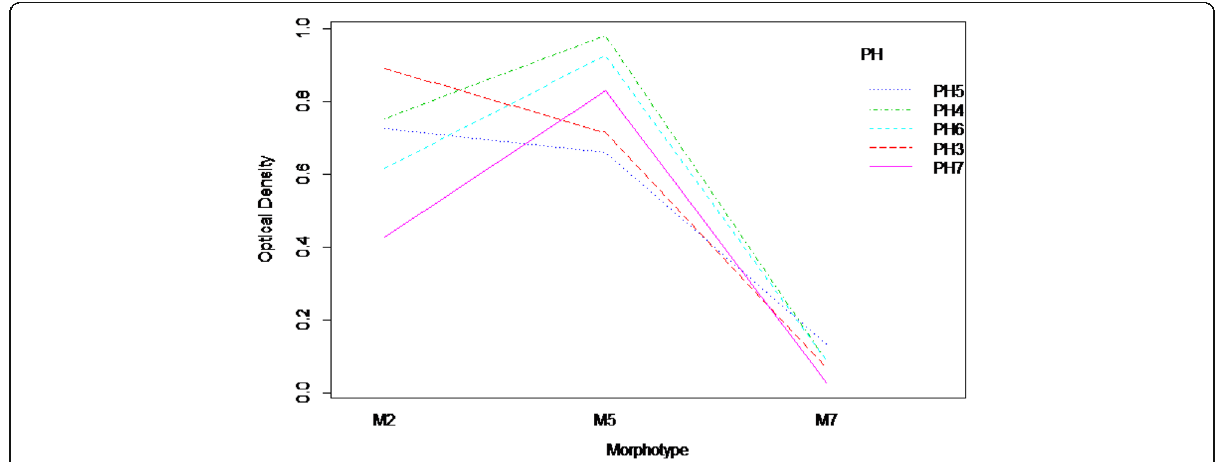
Fig. 2 Growth of antagonistic yeast morphotypes: M2, M5 and M7, under different pH values. Growth was measured by optical density at 540 nm after 48 h under the evaluated pH. The two-way ANOVA indicated significant effects for pH ( F = 3.47; P = 0.019; df = 4) and morphotype ( F = 203.98; P < 0.05; df = 2) and a highly significant interaction effect ( F = 4.74; P = 0.00077; df =